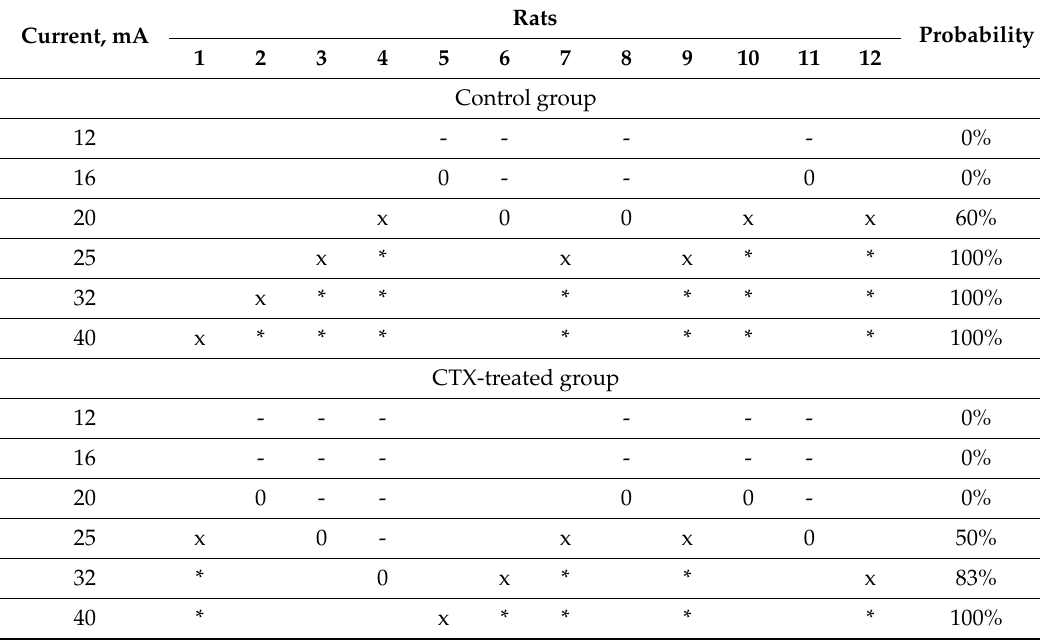
Table A1. Results of the MEST test.